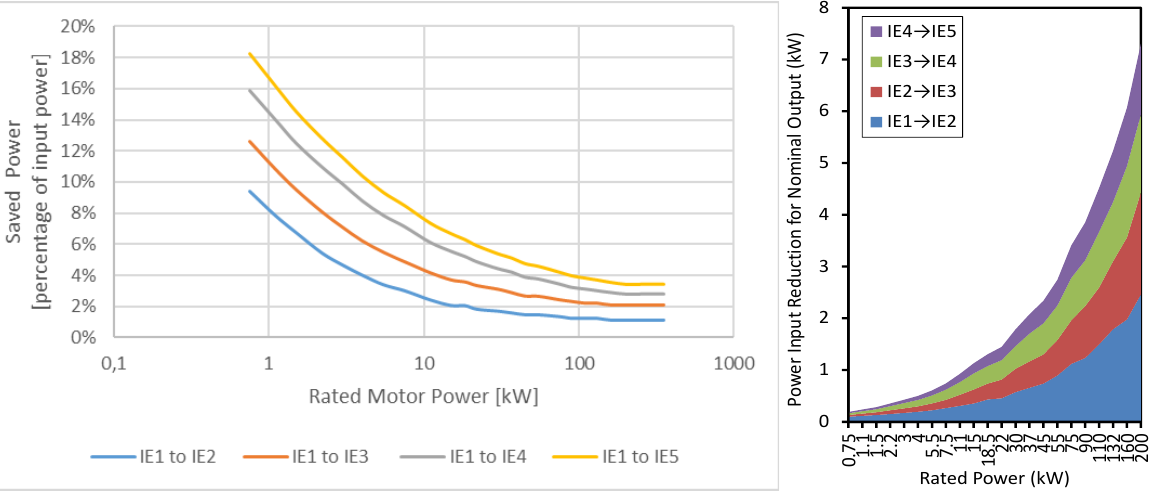
Figure 6. Potential power savings at full load by improvement of motor efficiency class (4-poles, 50Hz) (Source: Authors).